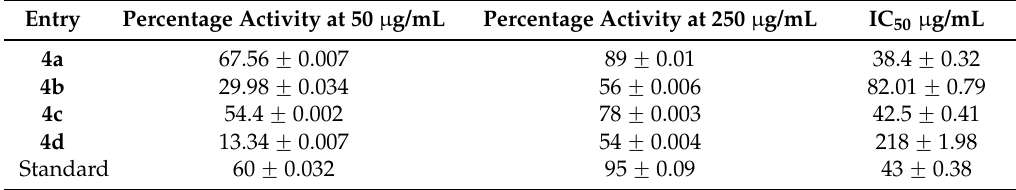
Table 5. Urease inhibition studies of 5-arylthiophene-2-sulfonylacetamides 4a – d .